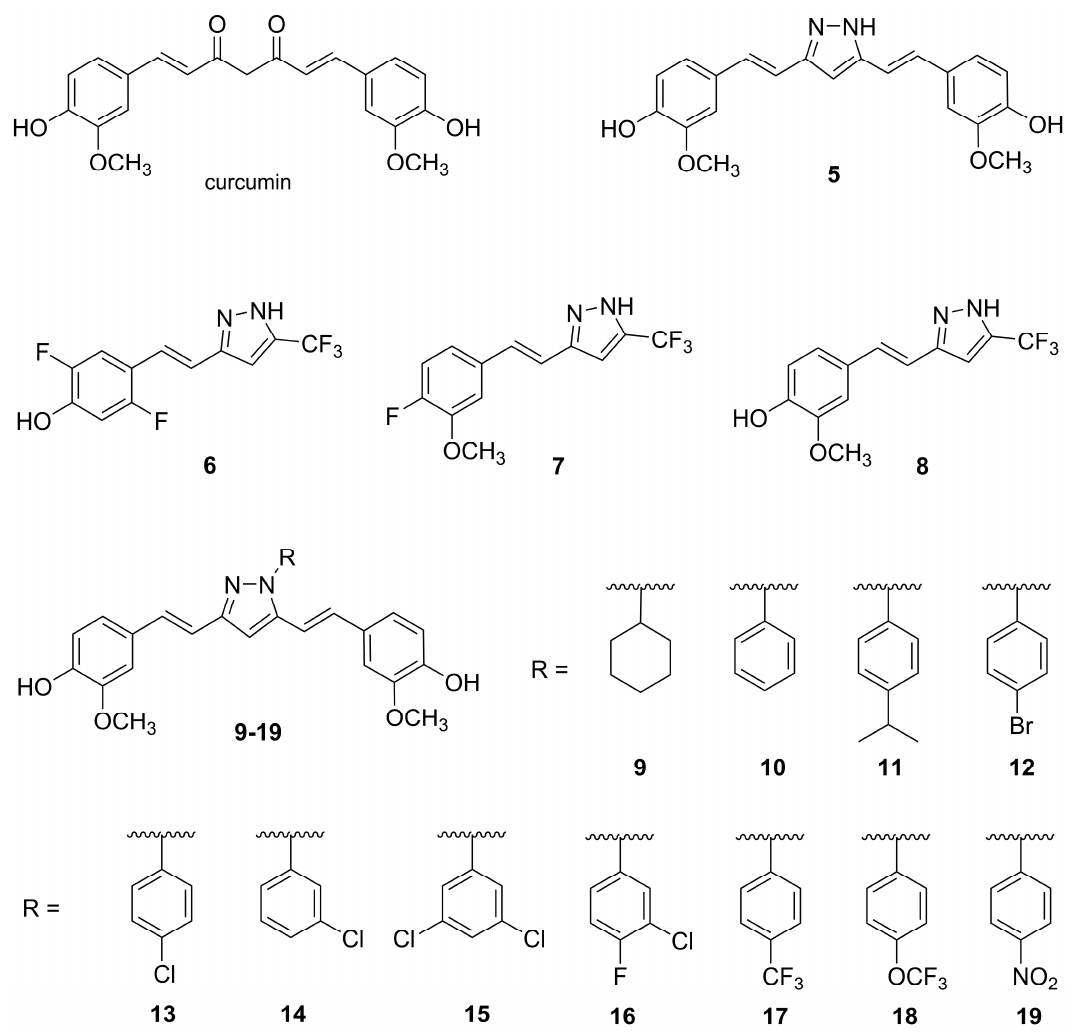
Figure 7. Structures of curcumin and of selected compounds from two families of curcuminoid pyrazoles: curcumin pyrazole, 5 ; the hemicurcumin pyrazoles 6 – 8 [41]; and the 1 H -substituted derivatives 9 – 19 [42].